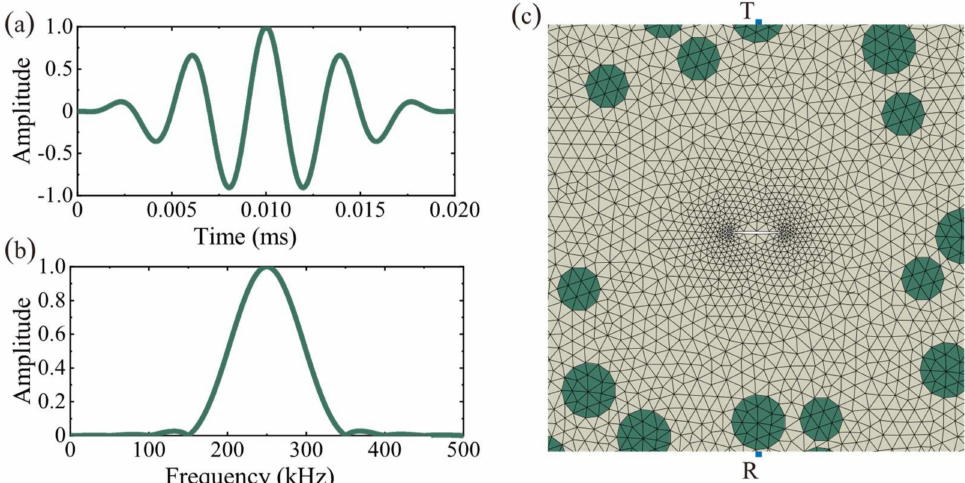
Figure 4. Numerical simulation configuration: ( a ) Source signal in the time domain signals (nor- malized amplitude); ( b ) Source signal in the frequency domain (normalized amplitude); ( c ) Mesh division and piezoelectric transducer distribution (T: Transmitter, R: